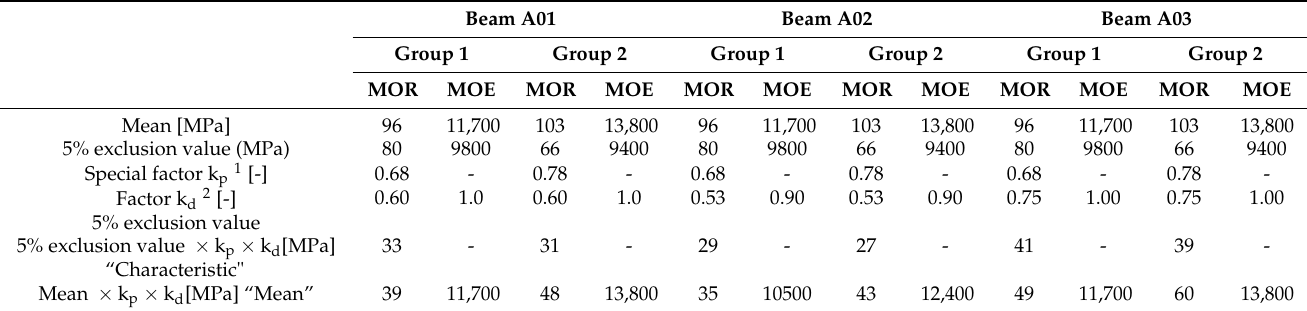
Table 18. Estimation of MOR and MOE of technical scale beams from small clear specimens according to the standard ASTM